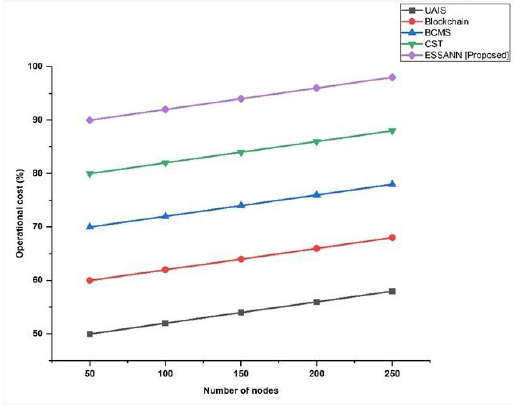
Figure 8. Comparison of operational cost [23 – 26].